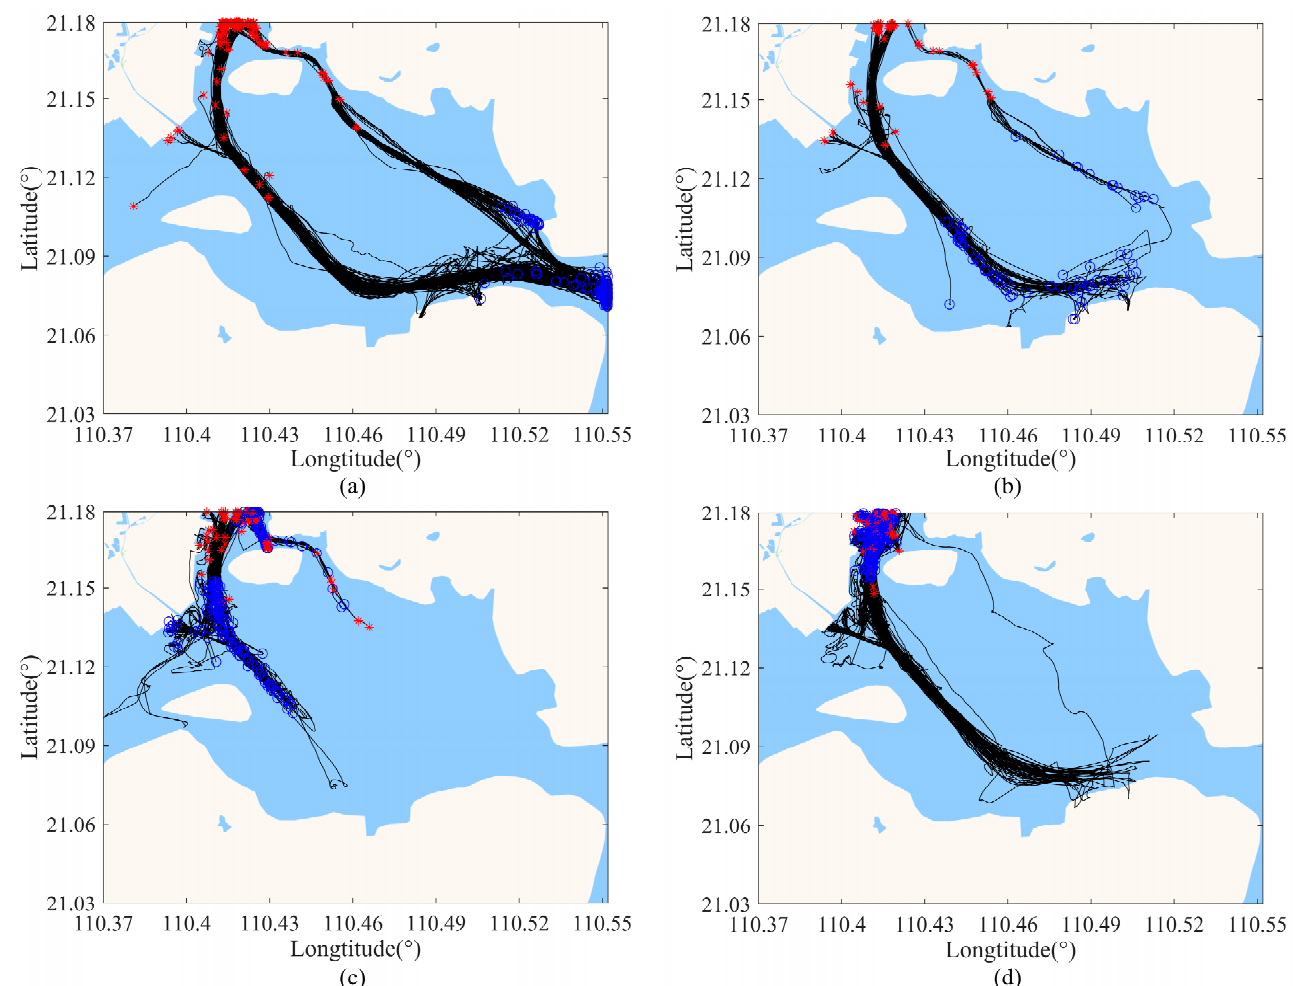
Figure 10. Trajectories with departures mainly near Area 4. ( a ) Area 4 to Area 1, 267; ( b ) Area 4 to Area 2, 80; ( c ) Area 4 to Area 3, 397; ( d ) Area 4 to Area 4, 586.